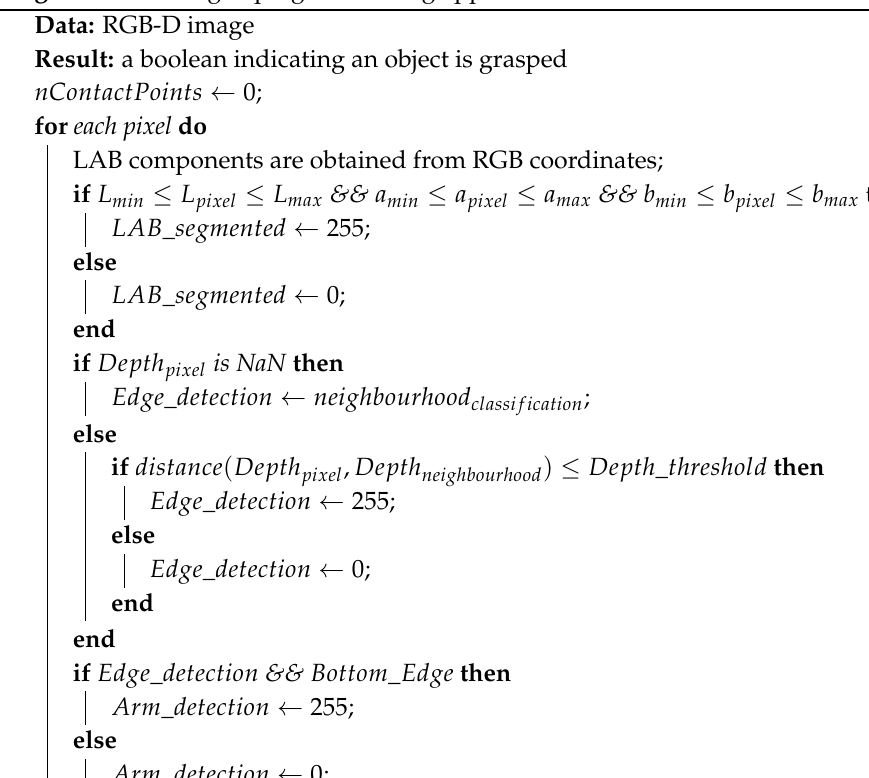
Algorithm 1: Our grasping monitoring approach. Data: RGB-D